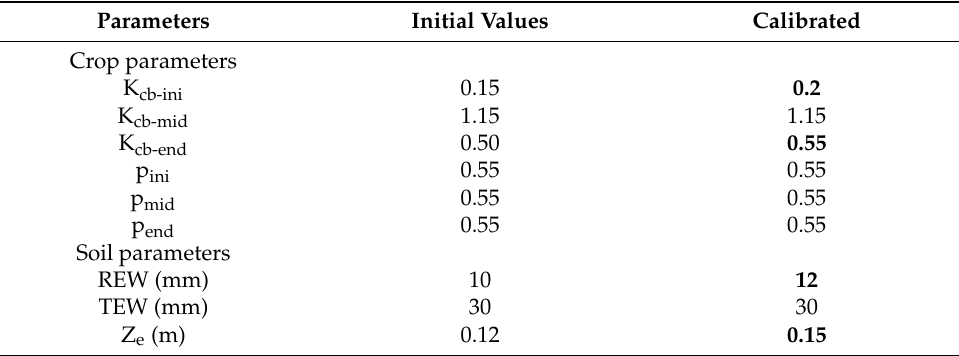
Table 3. Initial and calibrated values of key parameters for the SIMDualKc model.